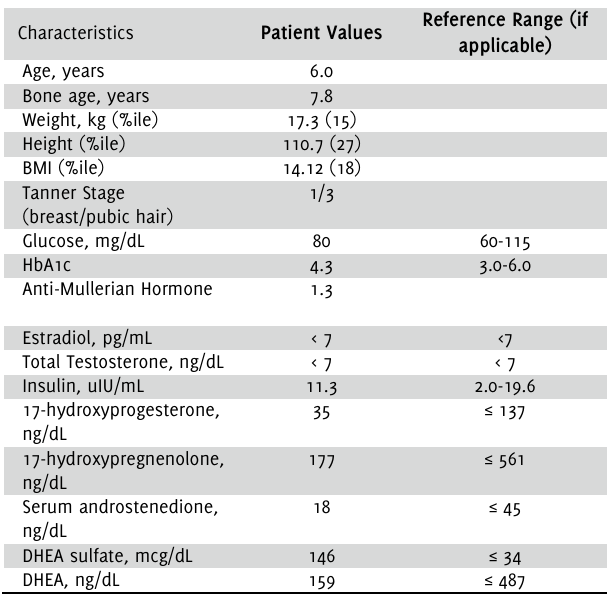
Table 1 . Clinical and laboratory findings at most recent